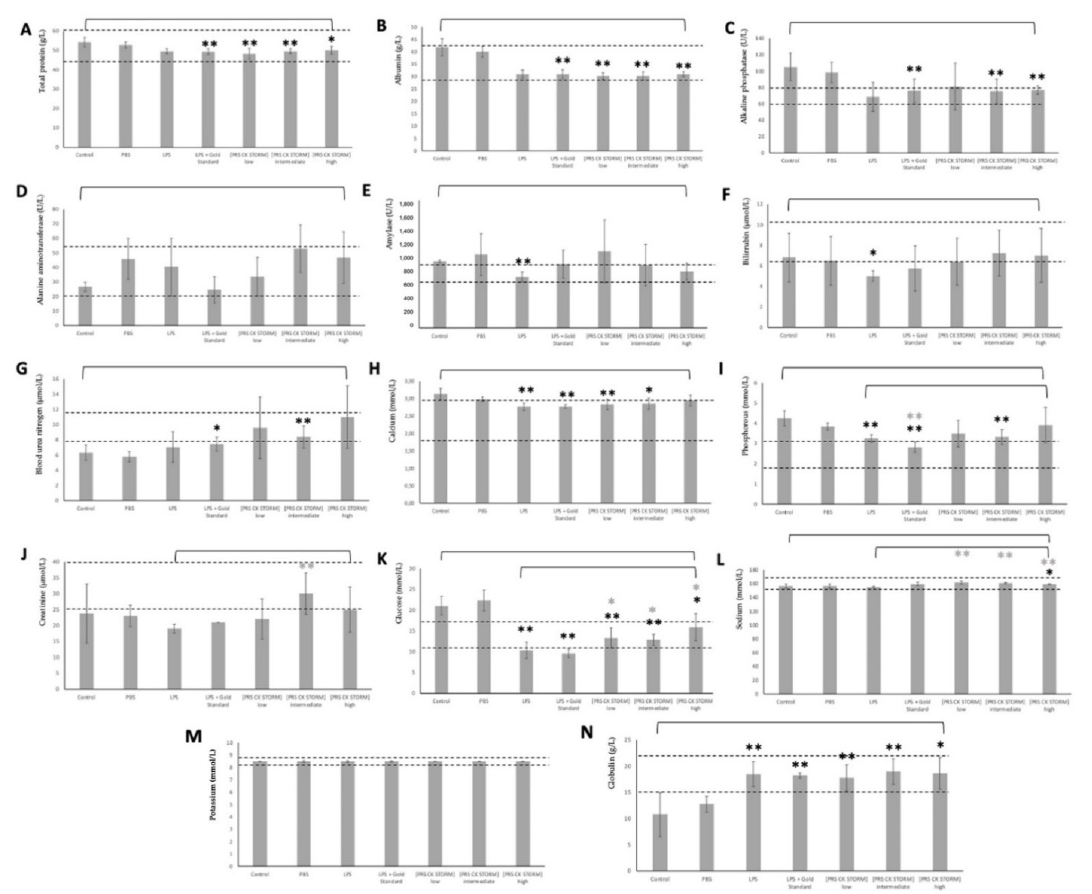
Figure 7. Analysis of biochemical parameters represented as the mean +/- SD from 8 samples. Blood samples were extracted from 8 out of 15 mice from day 0 (before treatment) and from each one of them at their respective experimental point (see Methodology). ( A ) shows the values of total protein in g/L, ( B ) shows the values of albumin in g/L, ( C ) shows the values of alkaline phosphatase in U/L, ( D ) shows the values of alanine aminotransferase in U/L, ( E ) shows the values of amylase in U/L, ( F ) shows the values of bilirrubin in µ mol/L, ( G ) shows the values of blood urea nitrogen in µ mol/L, ( H ) shows the values of calcium in mmol/L, ( I ) shows the values of phosphorous in mmol/L, ( J ) shows the values of creatinine in µ mol/L, ( K ) shows the values of glucose in mmol/L, ( L ) shows the values of sodium in mmol/L, ( M ) shows the values of potassium in mmol/L, and ( N ) shows the values of globulin in g/L. The Mann-Whitney test was used for statistical significance (* p < 0.1; ** p < 0.05), comparing the control group with the other groups (dark black asterisks), and the same test between the LPS group and the groups treated with either PRS CK STORM or Gold Standard (light grey